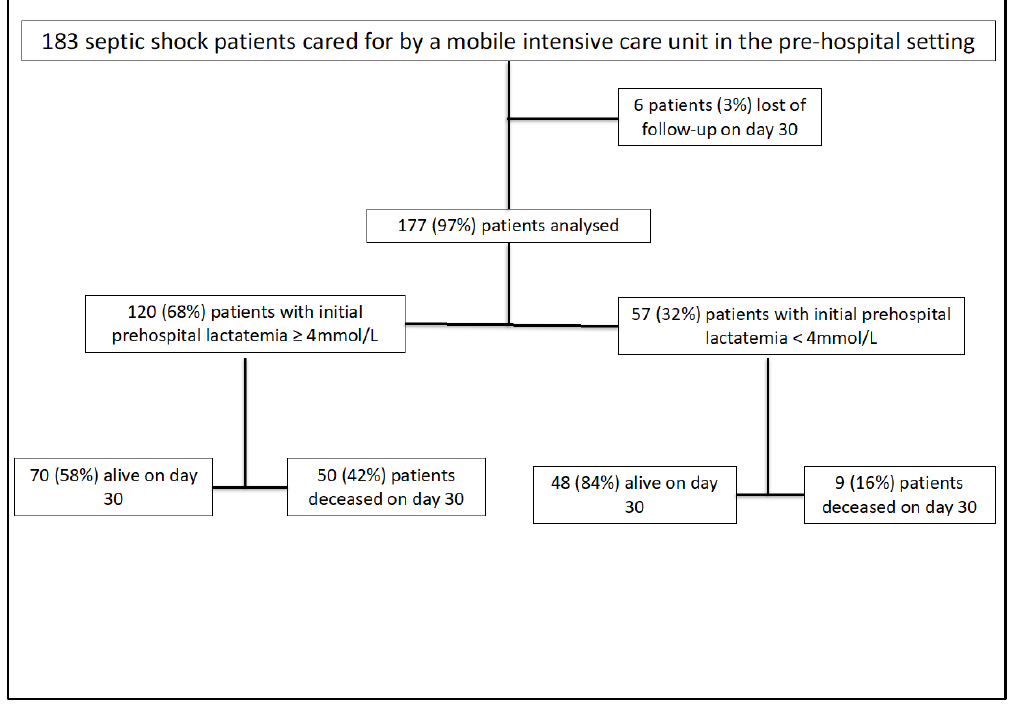
Figure 1. Flow Figure 1. Flow chart.